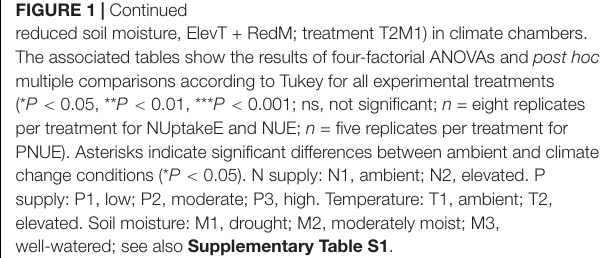
regression lines: R 2 = 0.23; Figure 3C